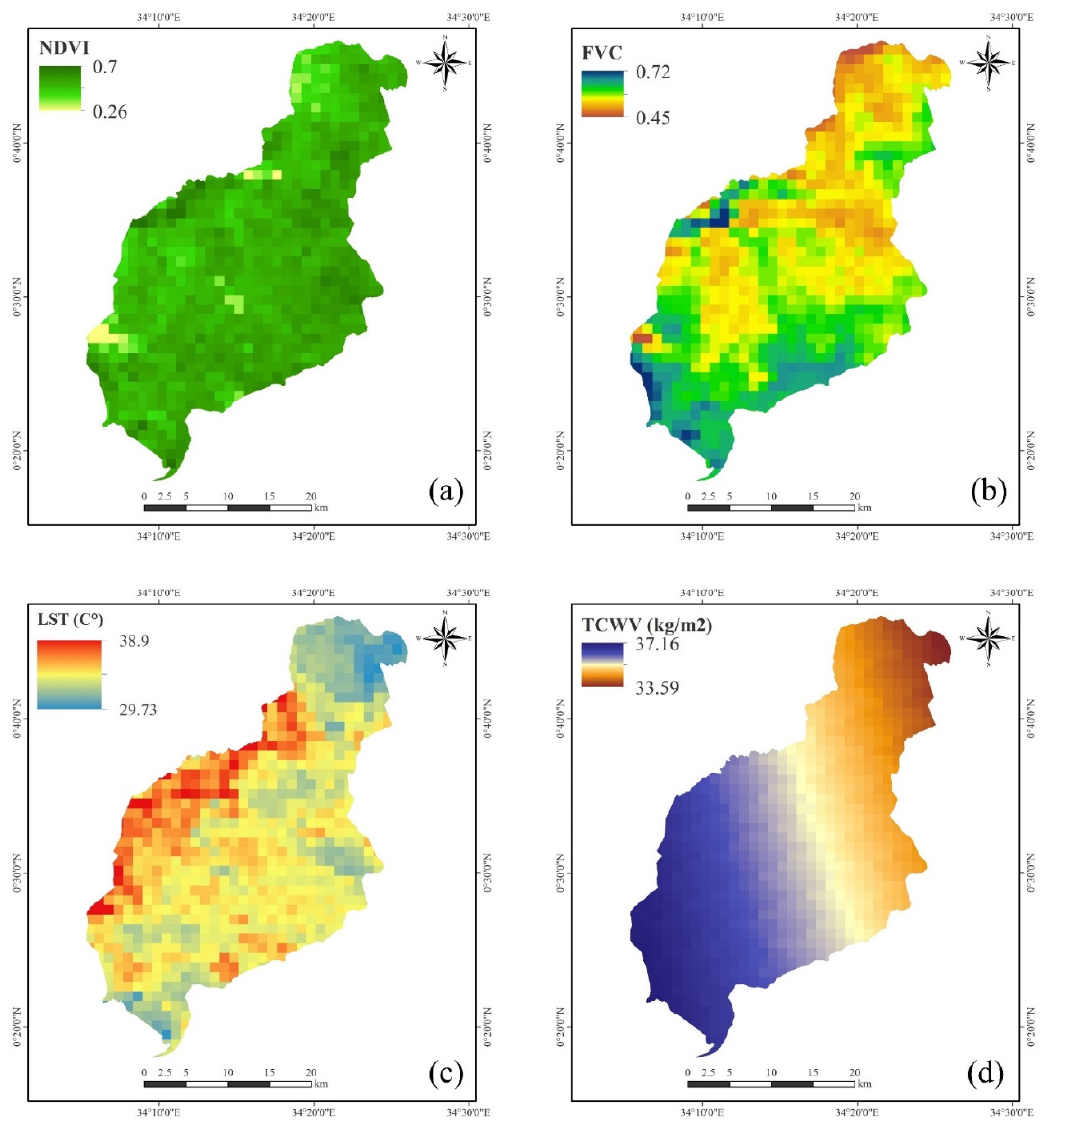
Figure 4. Variables derived from Sentinel-3 SLSTR data: ( a ) NDVI, ( b ) FVC, ( c ) LST, and ( d ) TCWV.